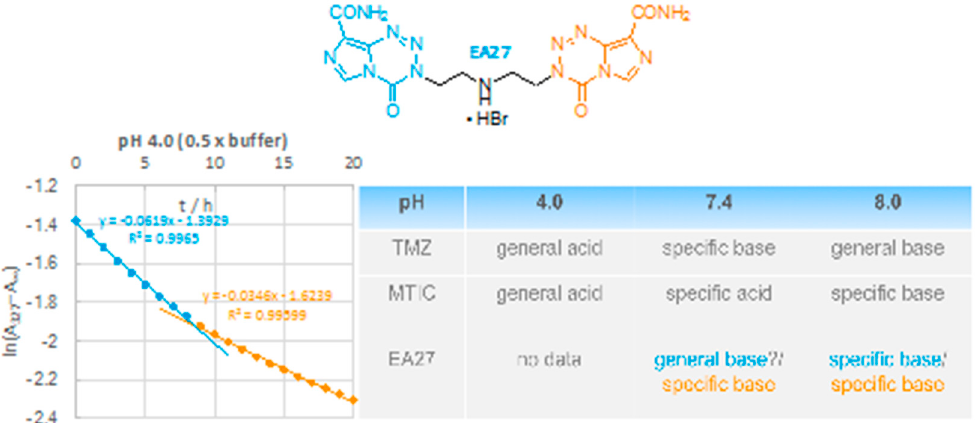
Figure 1. EA27 (top), example hydrolysis data (L) and the prodrug activation mechanisms determined (R).